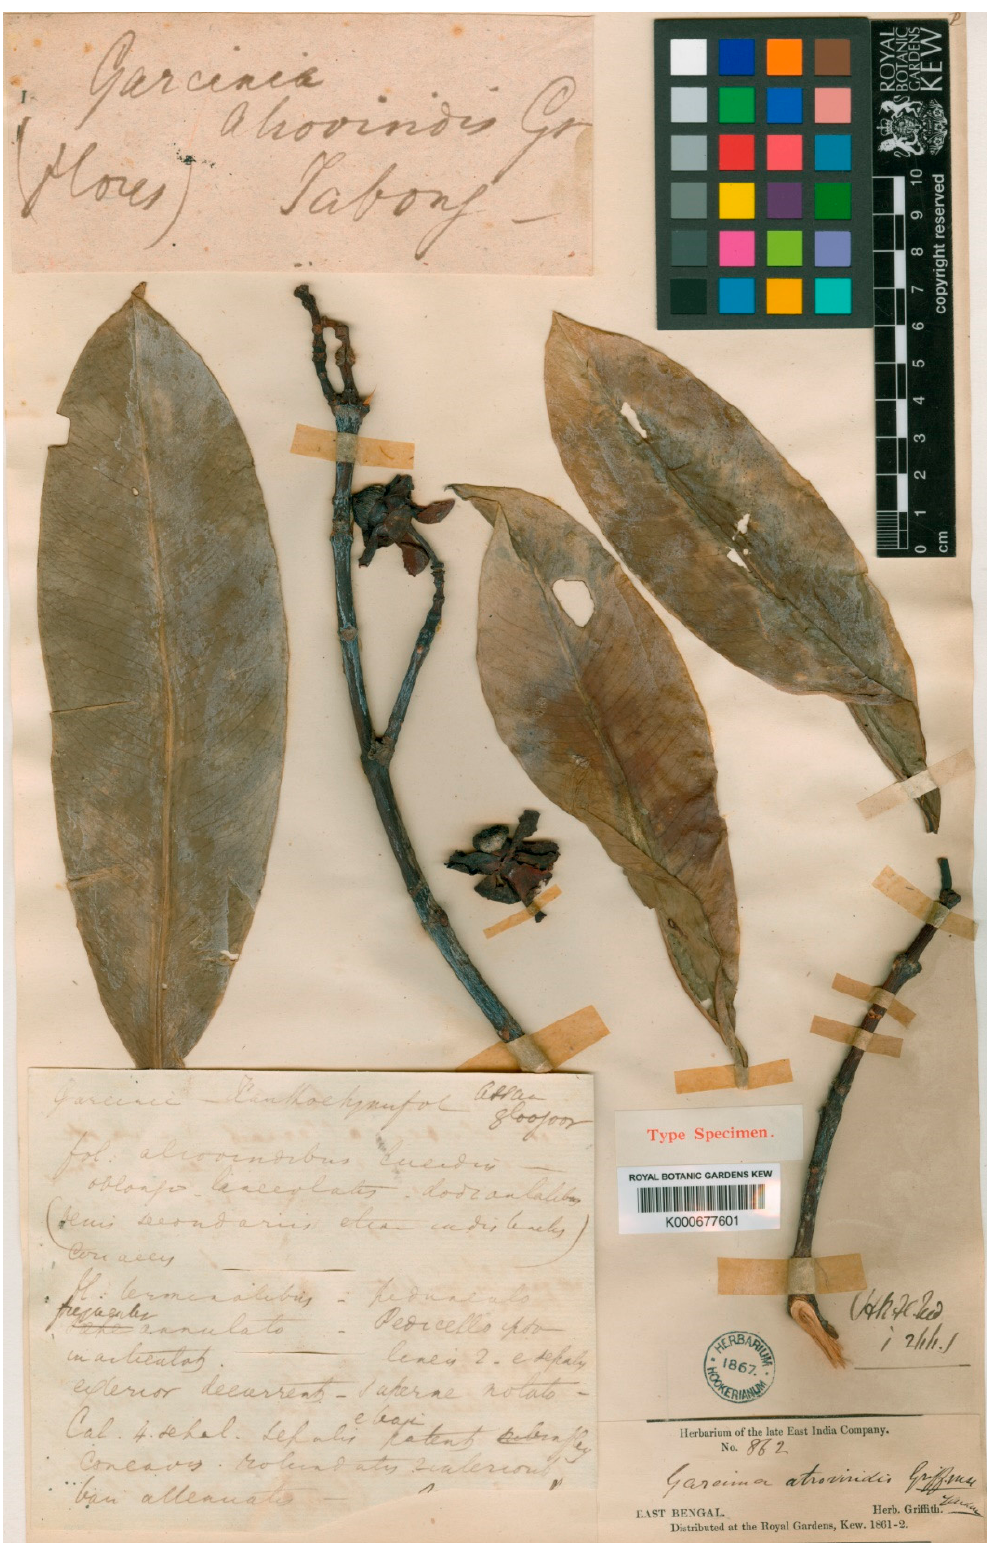
Figure 1. Lectotype of Garcinia atroviridis , Griffith 862 (K [K000677601!]) from India, Upper Assam, Tabong, with female flowers and very young fruits (http://specimens.kew.org/herbarium/K000677601, accessed on 16 February 2022).